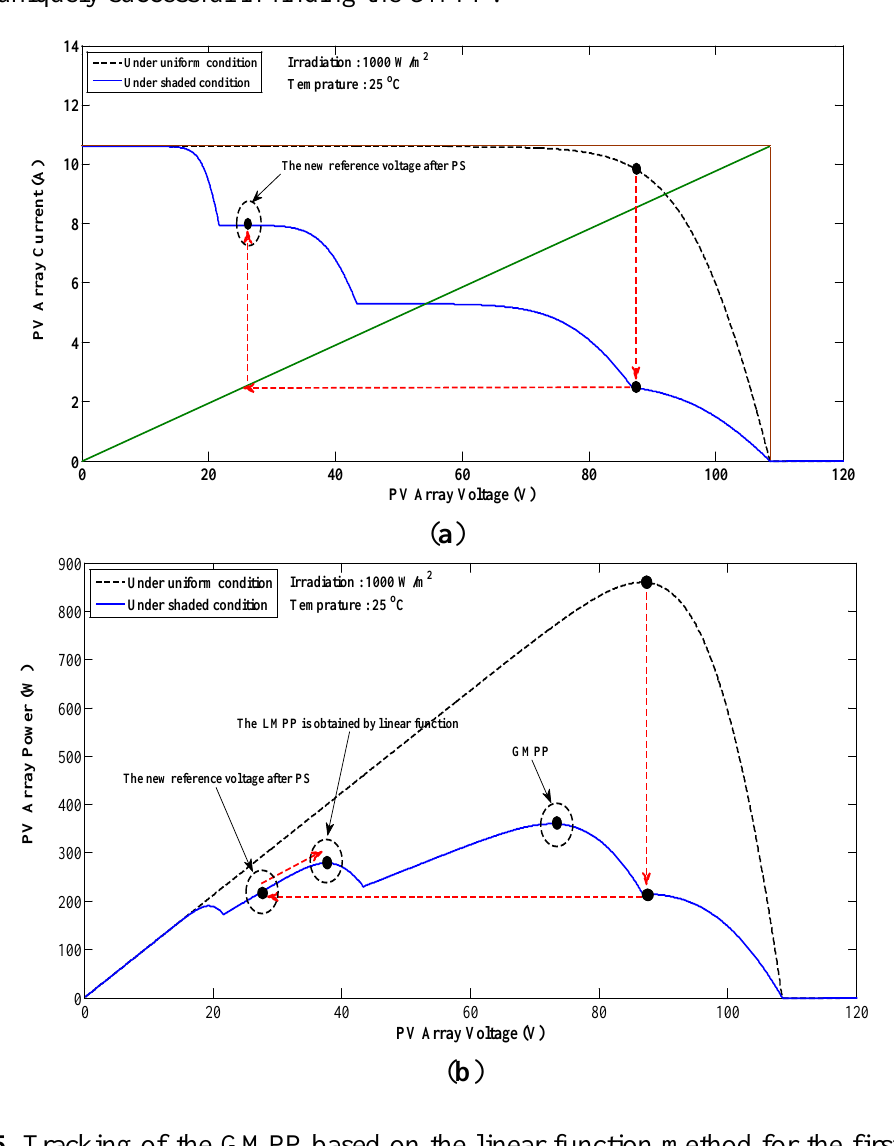
Figure 5. Tracking of the GMPP based on the linear function method for the first case of the complicated scenario ( a ) I-V curve and ( b ) P-V